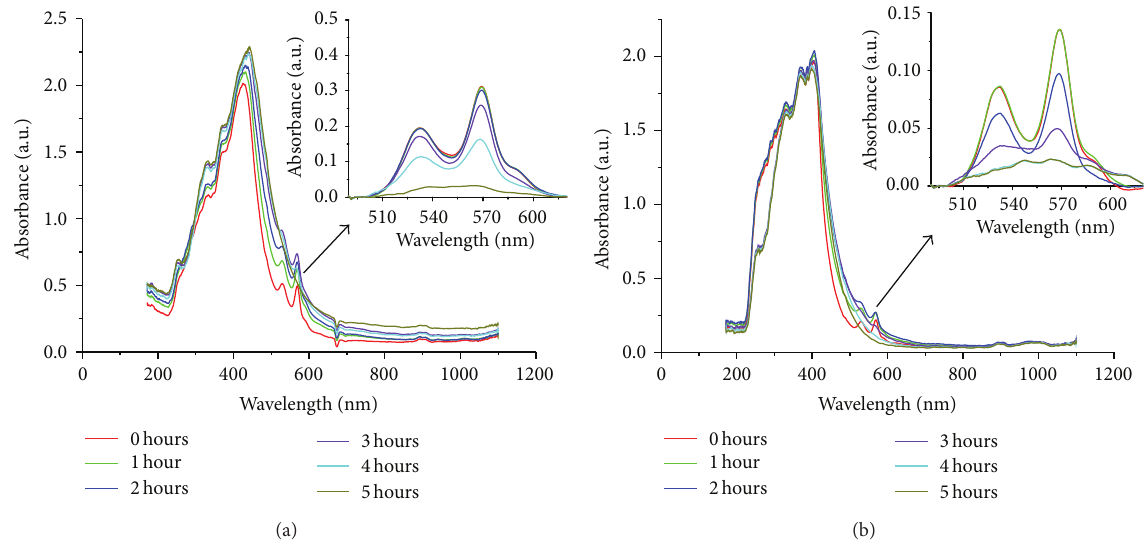
Figure 5: UV-Vis absorbance spectra as a function of illumination time in the presence of the N-TiO 2 /Cu nanomaterial with the crude oil extracts: (a)COE-(N-TiO 2 /Cu)and (b)COEW-(N-TiO 2 /Cu).Theinsetsshowthebandsobserved at 530 nmand 569 nmwiththebackground subtracted.